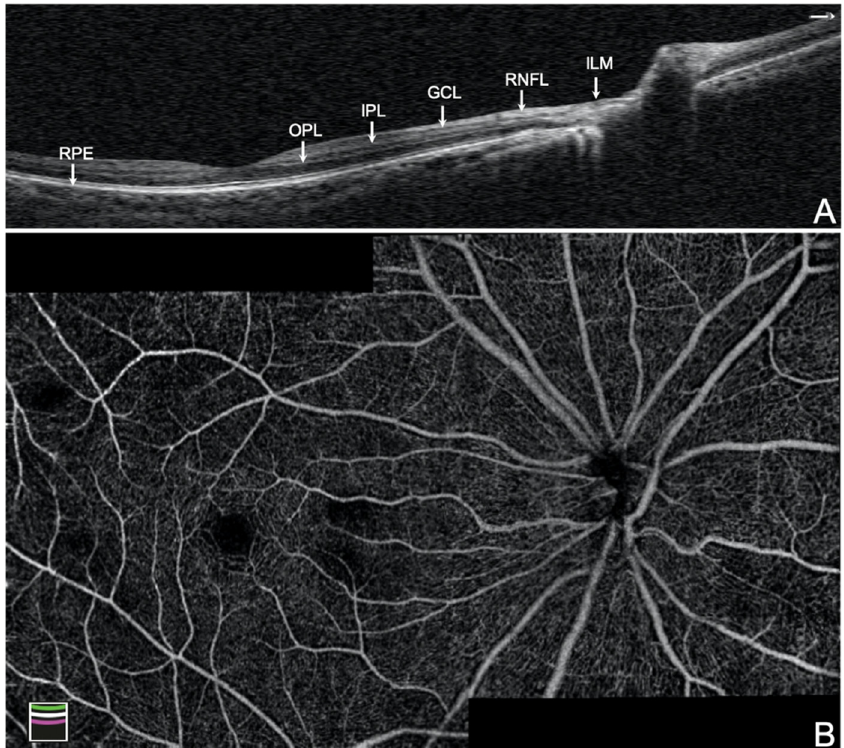
Figure 1. Composition of the retinal vascular plexus. ( A ) The cross-section of wide-field optical coherence tomography of disc and macula. ( B ) The montage mode of 6 × 6 mm 2 optical coherence tomography angiography of disc and macula algorithm of a normal eye. SVC = superficial vascular complex (plexus of RNFL + GCL + IPL); RNFL = retinal nerve fiber layer; GCL = ganglion cell layer; IPL = inner plexiform layer; DVC = deep vascular complex (plexus of IPL to OPL); OPL = outer plexiform layer; ILM = internal limiting membrane; RPE = retinal pigmented epithelium.